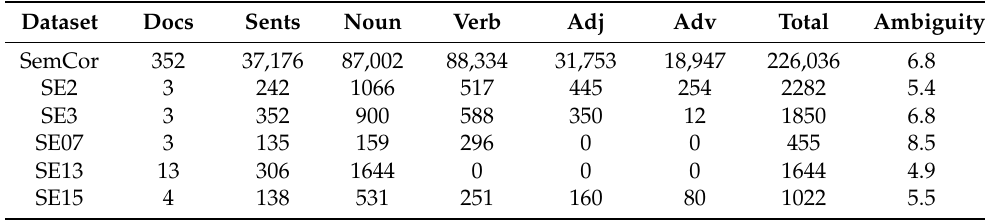
Table 1. Statistics include the number of documents (Docs) and sentences (Sents) as well as the number of the sense annotations of noun (Noun), verb (Verb), adjective (Adj), adverb (Adv, and total of above four parts-of-speech (Total). The last column shows the ambiguity level of each dataset. Dataset Docs